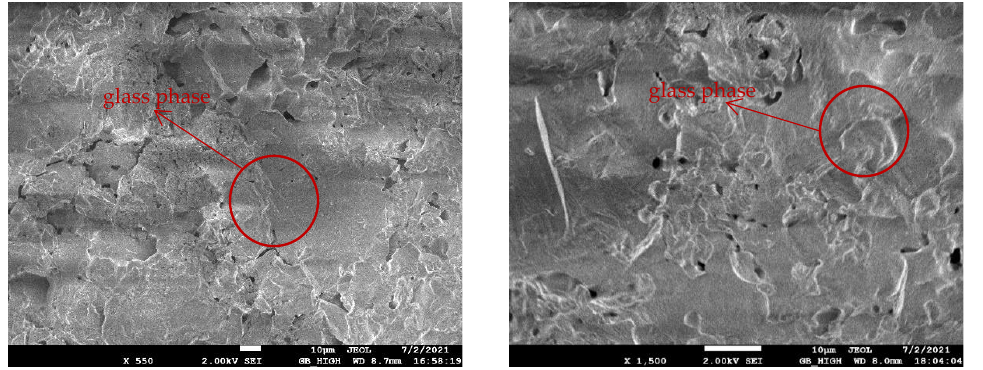
Figure 24. SEM micromorphology of MGS sintered brick.